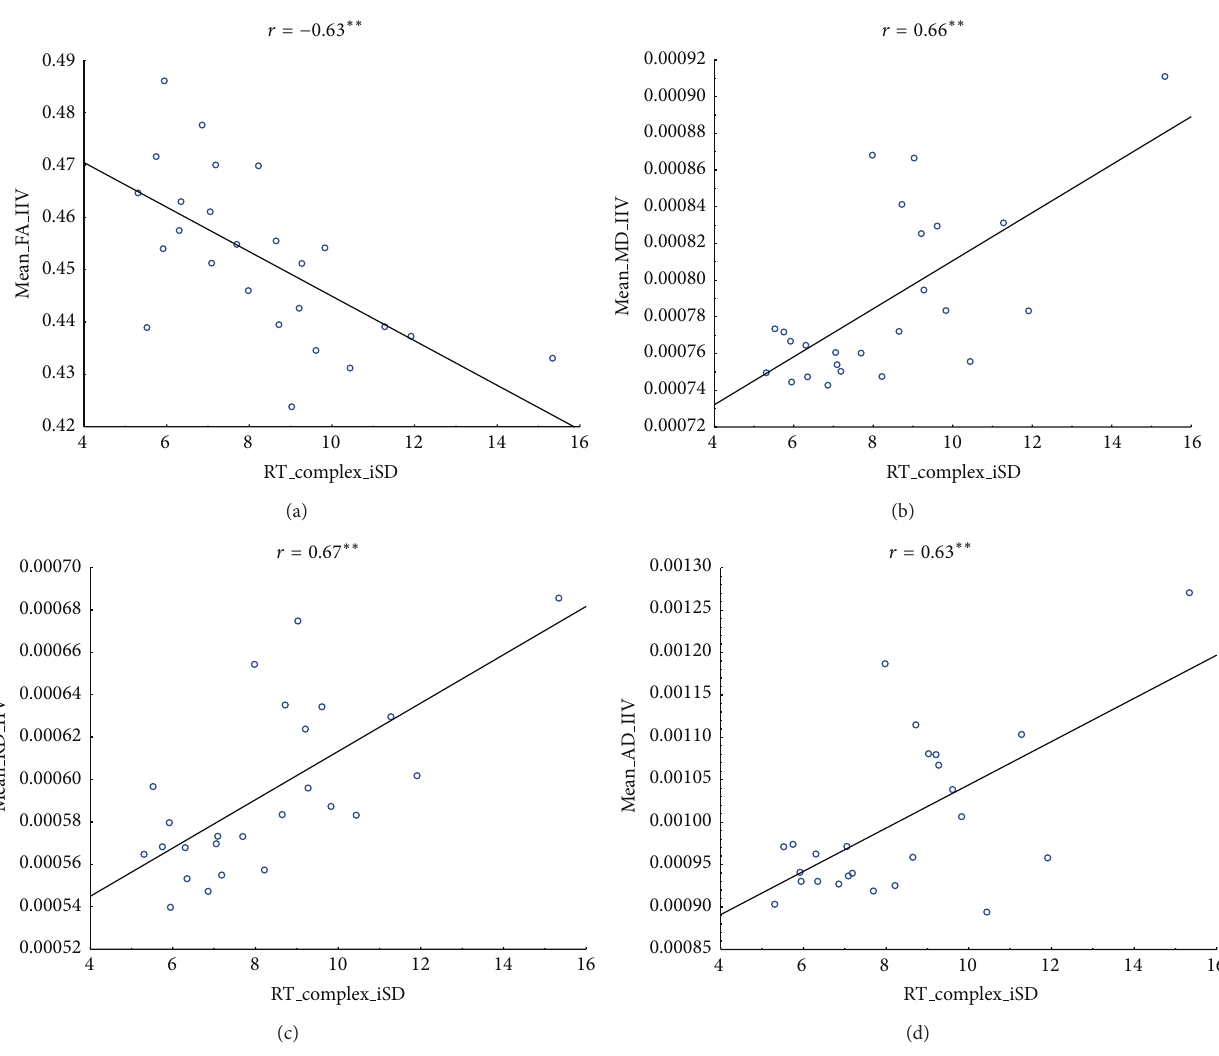
Figure 5: Scatterplots of iSD in the complex processing speed task and DTI characteristics (FA, MD, RD, and AD). For illustration, only ROIs showing significant correlations with IIV have been considered. IIV in processing speed was negatively related to fractional anisotropy and positively related to diffusivity (MD, AD, and